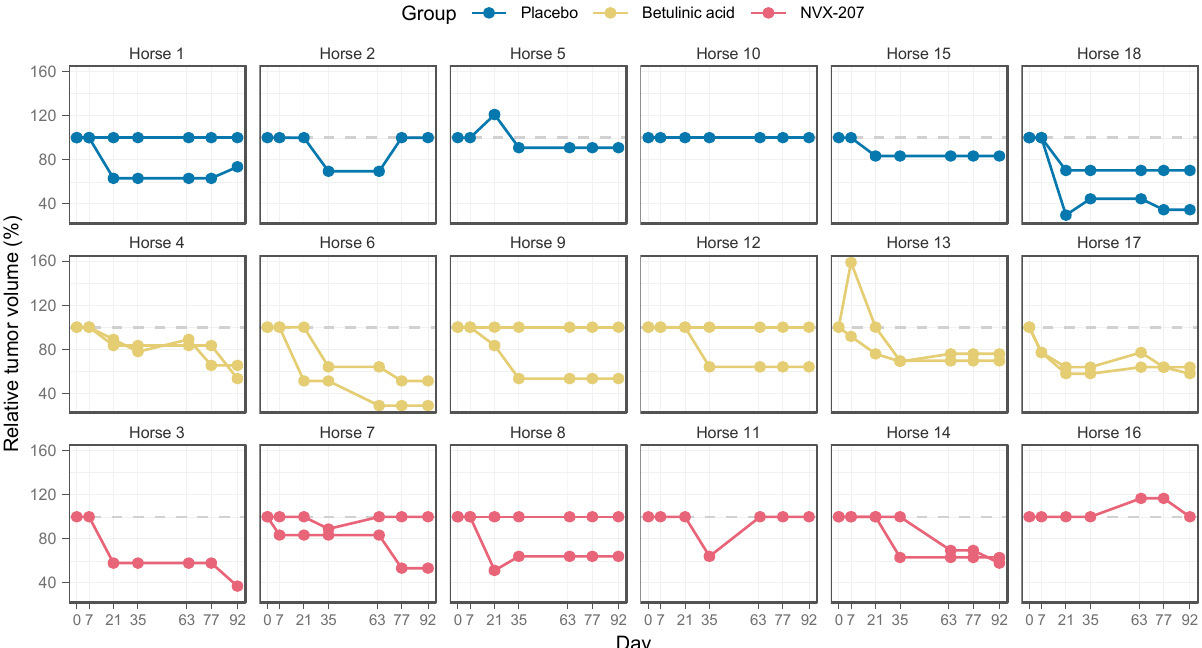
Figure 2. Relative tumor volumes over time for the individual horses. Equine melanomas were treated topically with a placebo, a 1% BA cream or a 1% NVX-207 cream twice daily for 91 consecutive days. The tumor volume before the initial treatment (day 0) corresponds to 100%, subsequent relative volumes are documented in percent of the baseline value. Depending on the number of tumors treated, one or two curves per horse are shown. In deviation from the statistical analysis, which is based on the absolute values, the values here are related to the baseline volume in order to achieve better visual comparability.